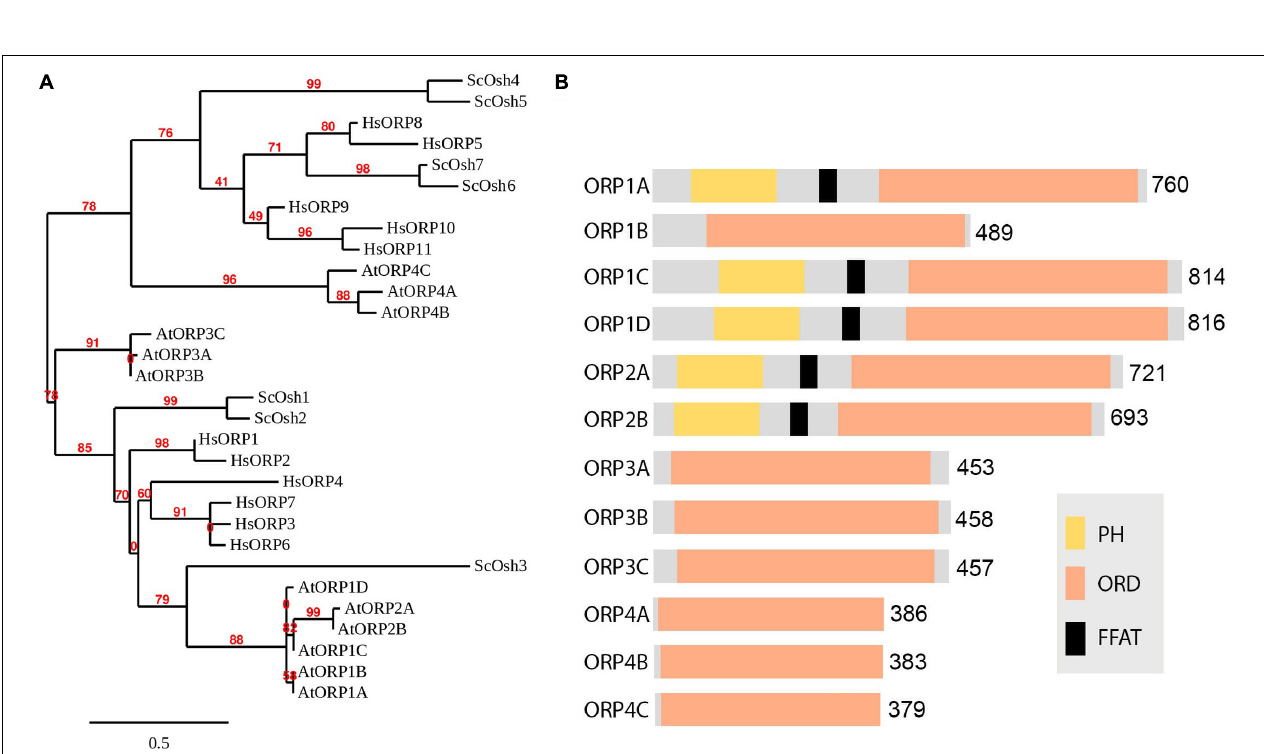
FIGURE 2 | Phylogenetic analysis of the Arabidopsis ORP family. (A) Phylogenetic tree of Oxysterol-binding Protein Related Proteins (ORPs) from Homo sapiens (Hs), Saccharomyces cerevisiae (Sc) and Arabidopsis thaliana (At) and viewed with MEGA4 program. Bar = 0.5. (B) Typical ORP contains both oxysterol-binding related domain ORD and PH domains, and a FFAT motif in between. Some potential VAP relevant core FFAT elements are not shown in the diagram as it can be very short which is commonly found in the sequence.